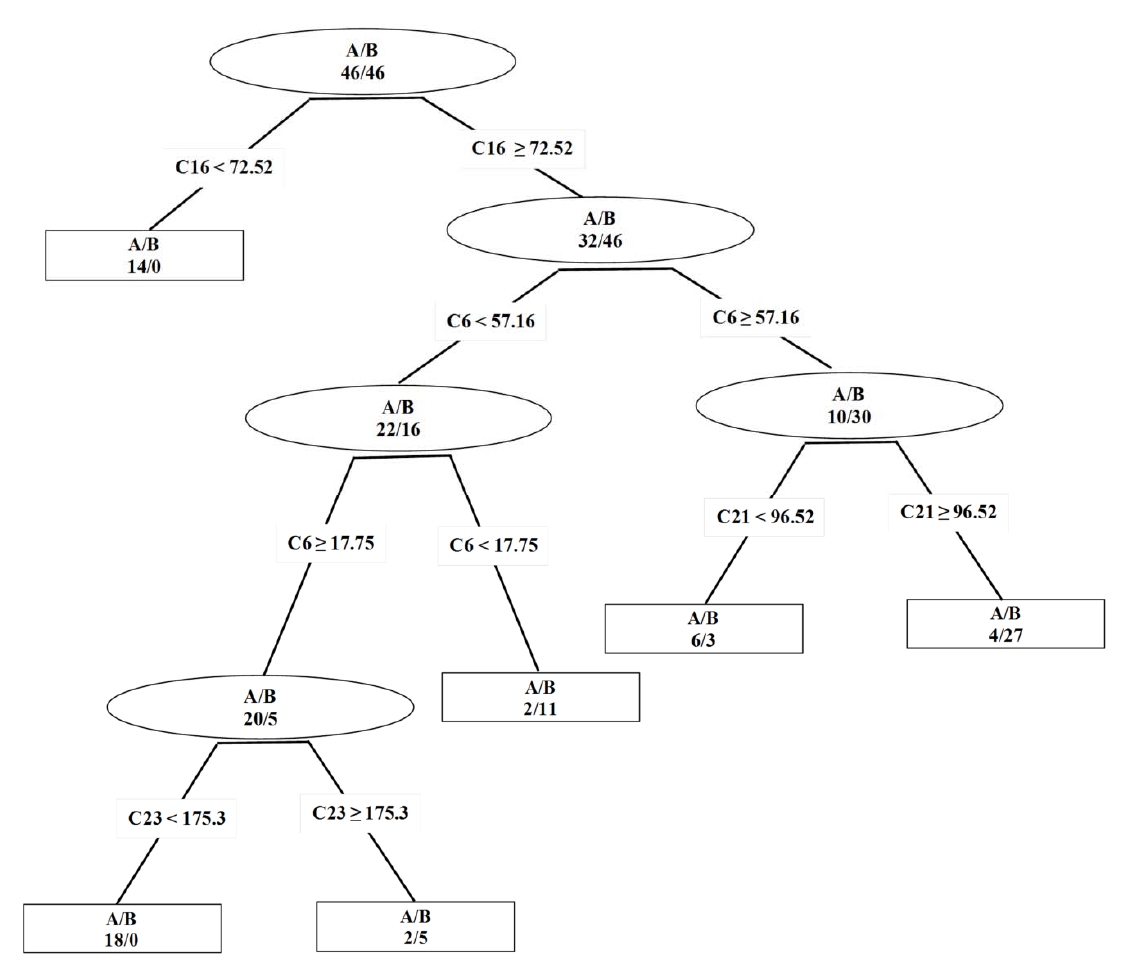
Figure 1. Representation of the classification tree derived with CART algorithm to distinguish the reducing end anomeric configuration of 92 trisaccharides (training